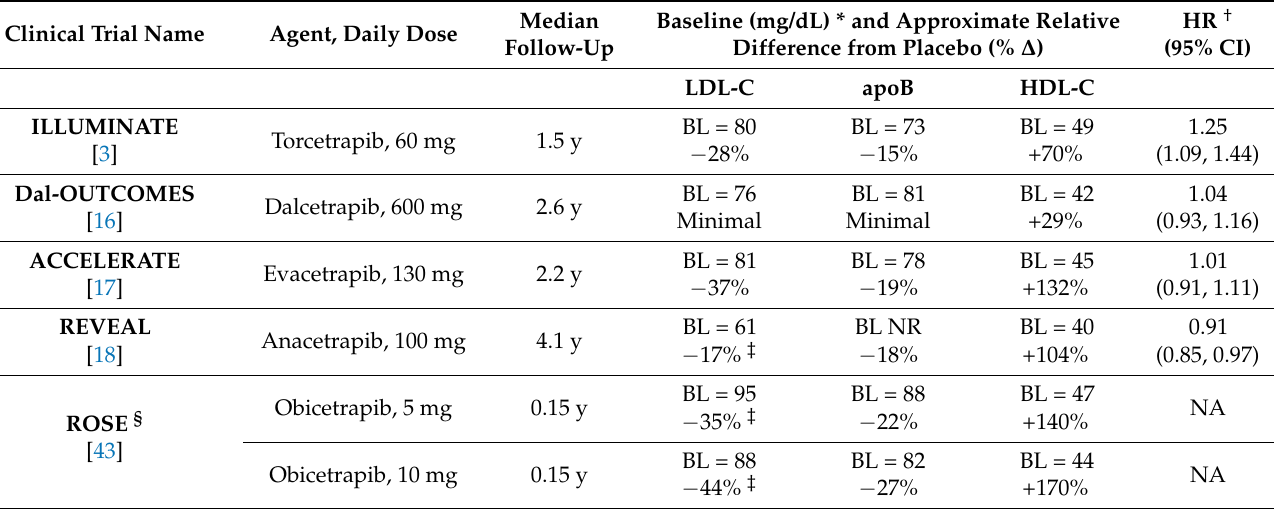
Table 1. Lipoprotein lipid, apolipoprotein B, and cardiovascular outcome results from trials with cholesteryl ester transfer protein